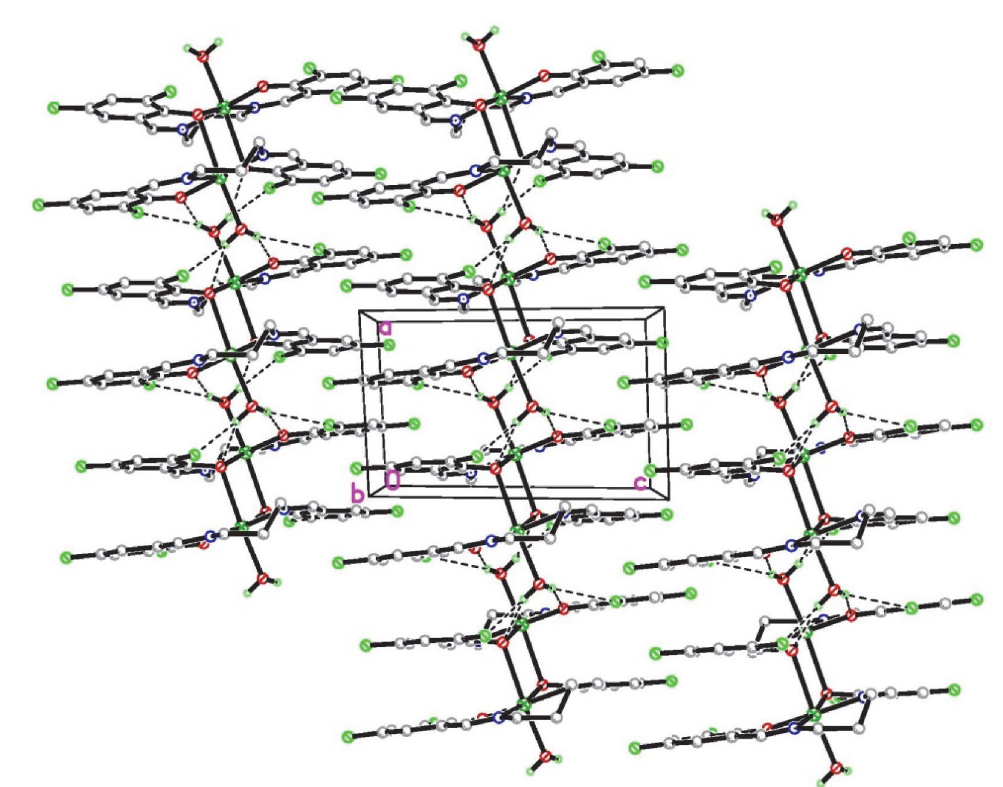
Figure 2. The hydrogen linked structure of complex 1 , viewed along the axis- b direction. Hydrogen bonds are shown as dashed lines.